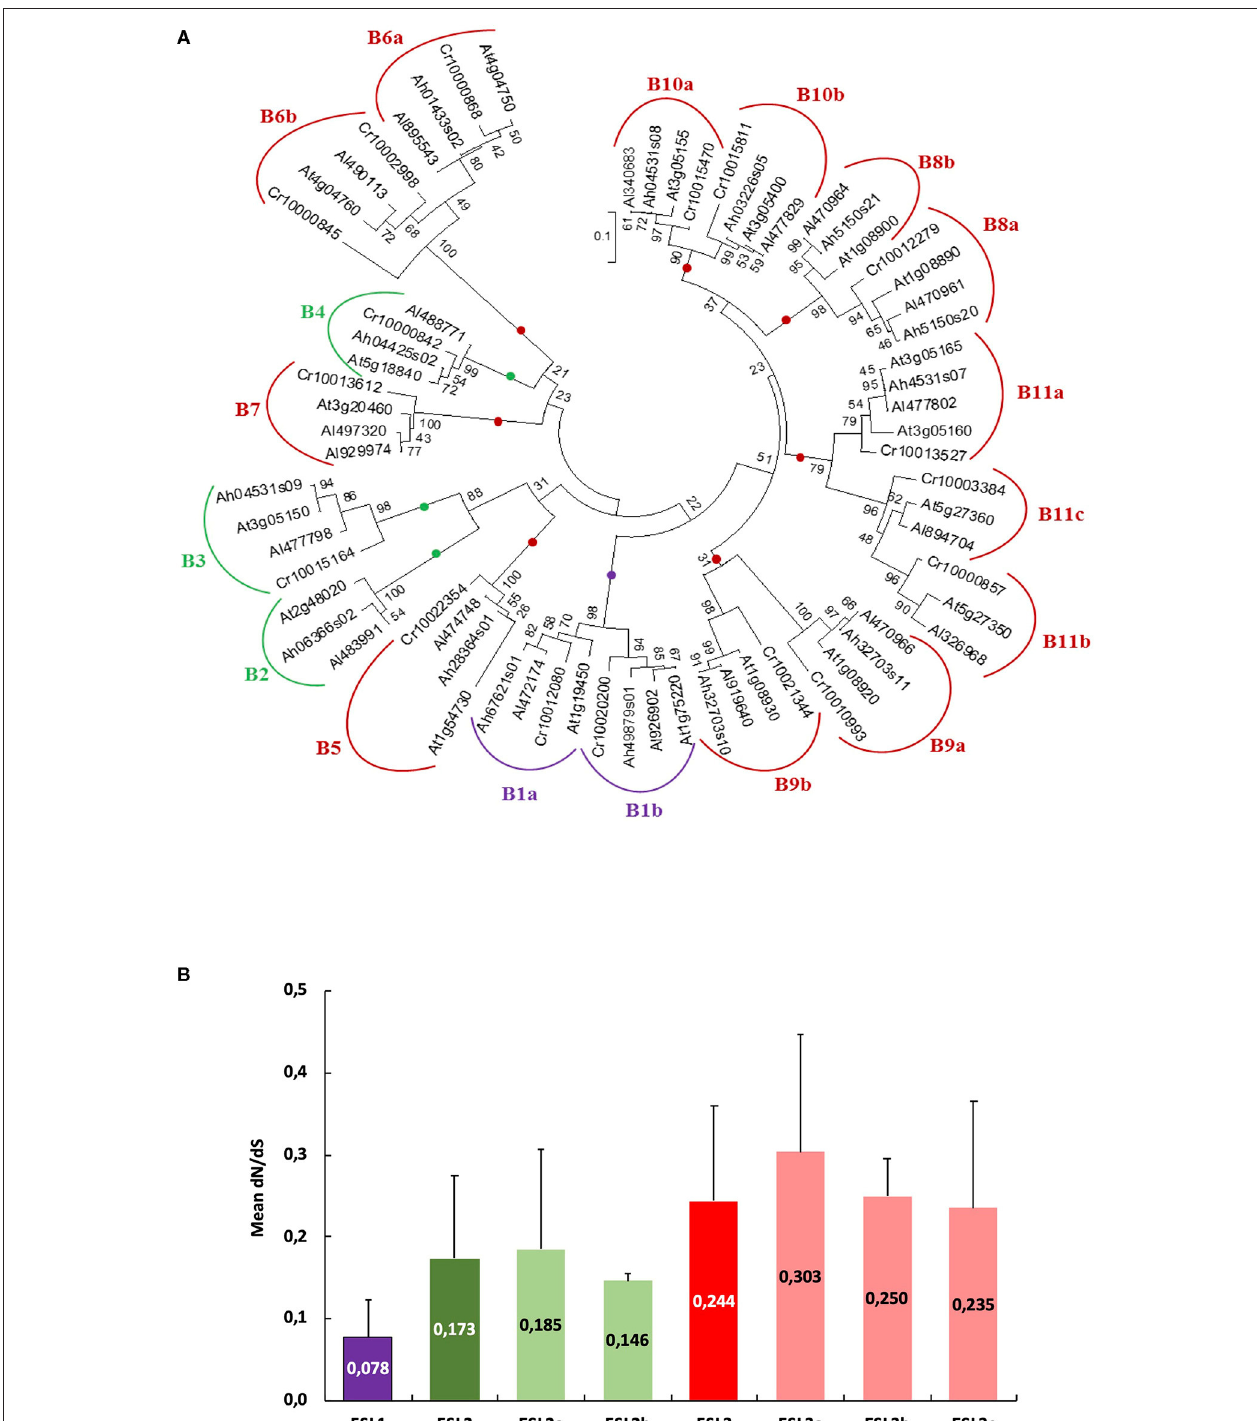
FIGURE 10 | Nucleotide substitution analysis (dN/dS) for Arabidopsis ESL . (A) Phylogenetic tree produced via the alignment, using ClustalW, of 69 nucleotide ESL sequences from Arabidopsis halleri , Arabidopsis lyrata , Arabidopsis thaliana , and Capsella rubella used as an outgroup. The tree was built by using the software Molecular Evolutionary Genetics Analysis (MEGAv7, Tamura et al., 2013). JTT amino acid substitution model was used and the bootstrap consensus tree was inferred from 1,000 replicates. Purple is for ESL1 , green for ESL2 , and red for ESL3. (B) The means of the dN/dS values in each ESL group. Group ESL1 = 8 sequences, group ESL2 = 10 sequences, group ESL2a = 7 sequences, group ESL2b = 3 sequences, group ESL3 = 48 sequences, group ESL3a = 4 sequences, group ESL3b = 11 sequences, and group ESL3c = 33.